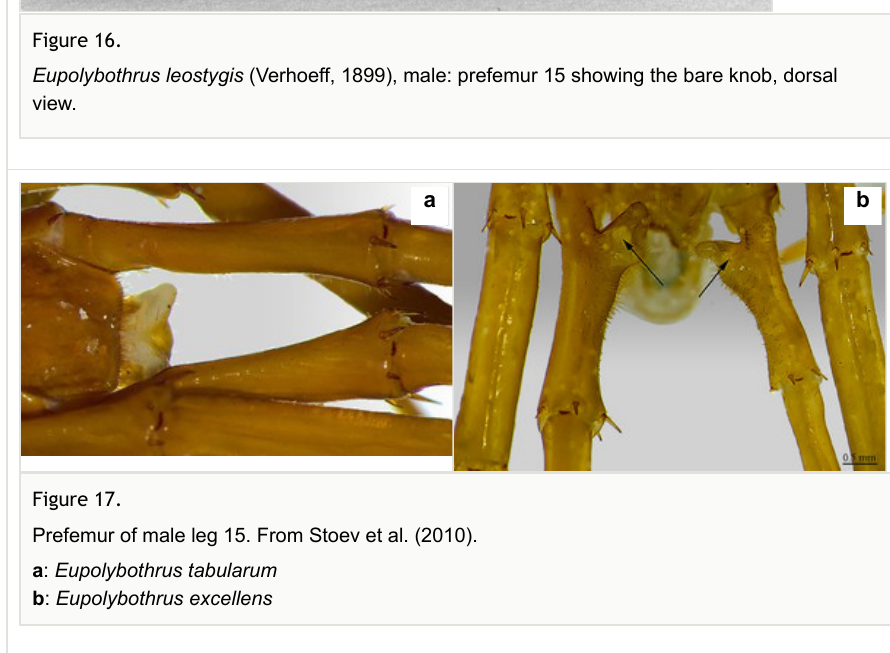
Eupolybothrus leostygis (Verhoeff, 1899), male: prefemur 15 showing the bare knob, dorsal